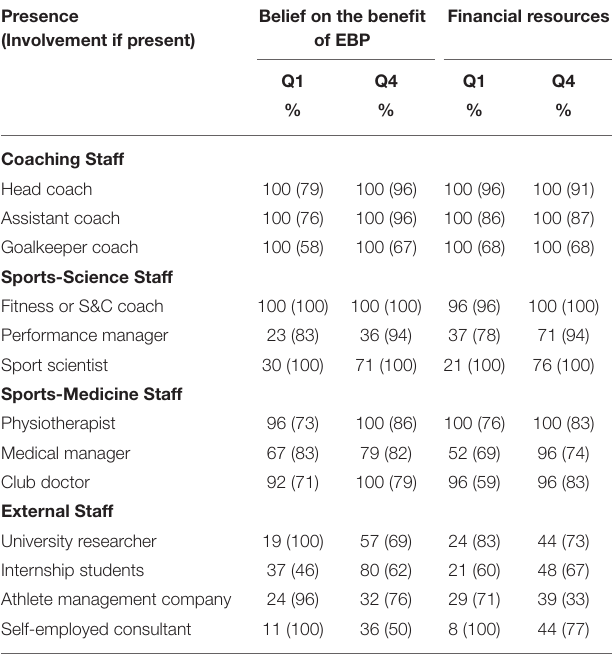
TABLE 4 | Presence (and involvement) of the different types of staff members in the monitoring process. Presence (Involvement if